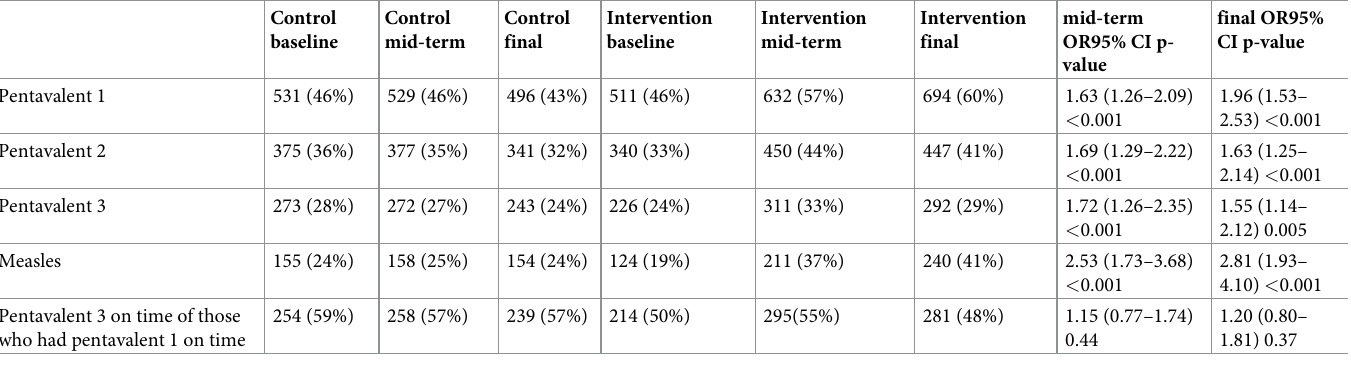
Table 5. Proportion that had timely pentavalent and measles